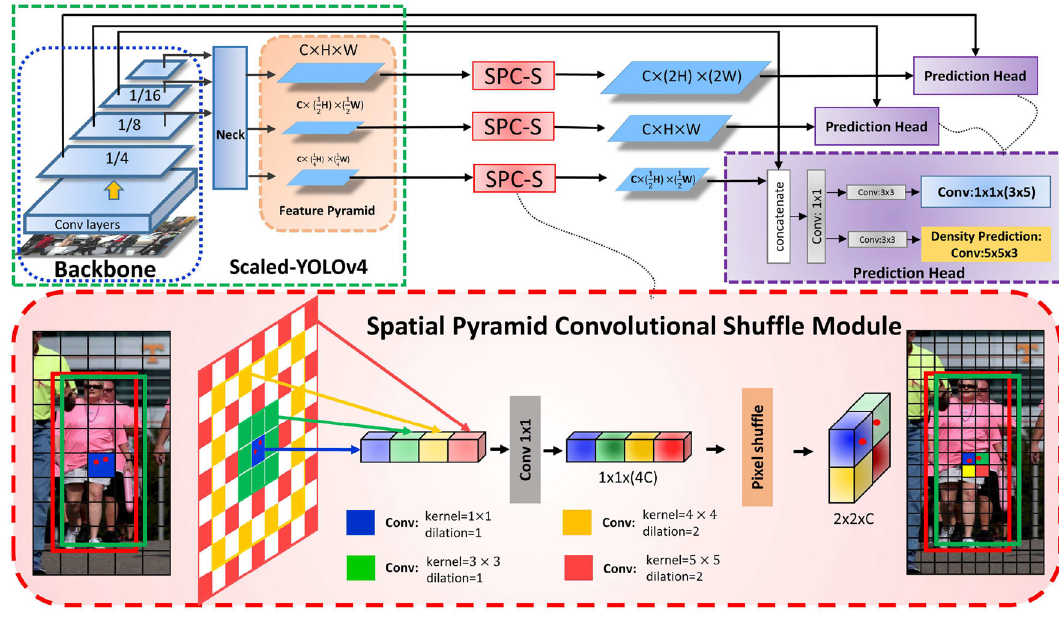
Fig. 2 The spatial pyramid convolutional shuffle module consists of 4 different convolutional kernels. The convolutional kernels with differ- ent sizes and dilation ratios cover different scopes, and their outputs are shuffled to generate distinguishable representations for heavily over-